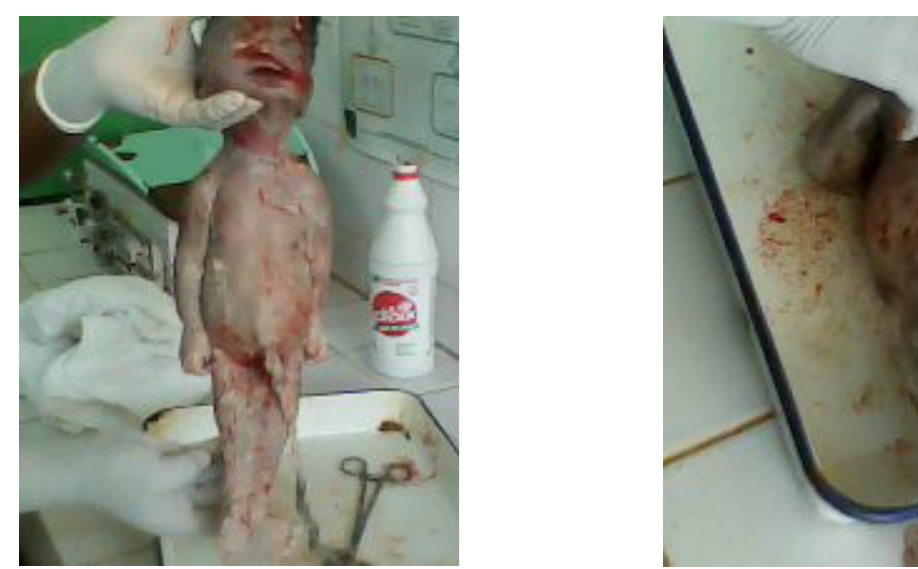
Figure 2. Complete morphological view of sirenomelic foetus.